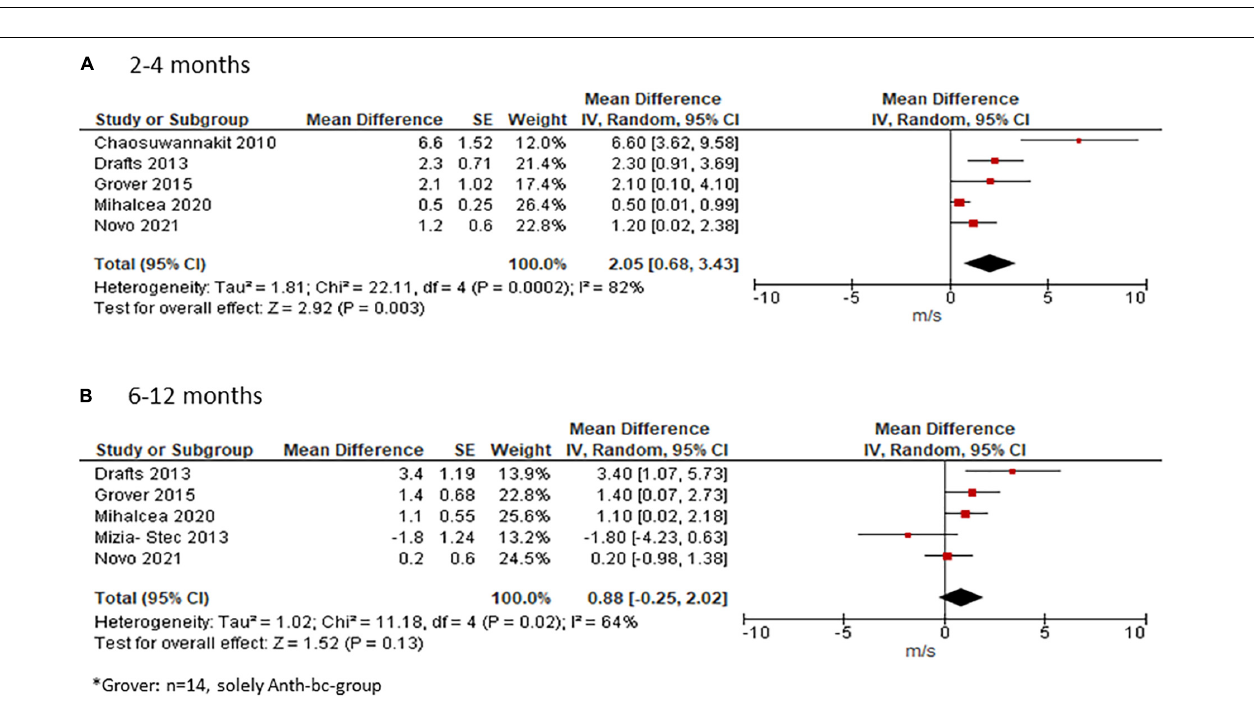
FIGURE 4 | Effect of ANTH-BC on PWV. Forest plot illustrating the effect of ANTH-BC on PWV divided by time-point of assessment into (A) short-term (2–4 months, corresponding to subgroup analysis for CMR) and (B) mid-term (6–12 months) effects.